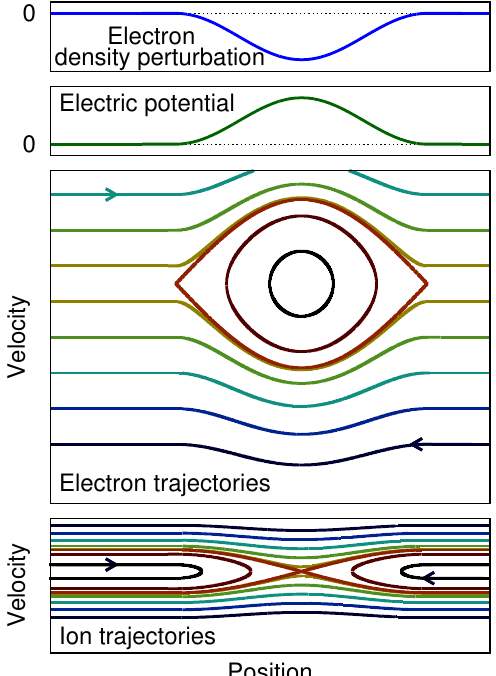
Figure 13. Cartoon of an electron hole in the reference frame of the hole. From top to bottom: electron density perturbation, electric potential, electron trajectories, and ion trajectories. Here, the scales are consistent with a mass ratio m i / m e =